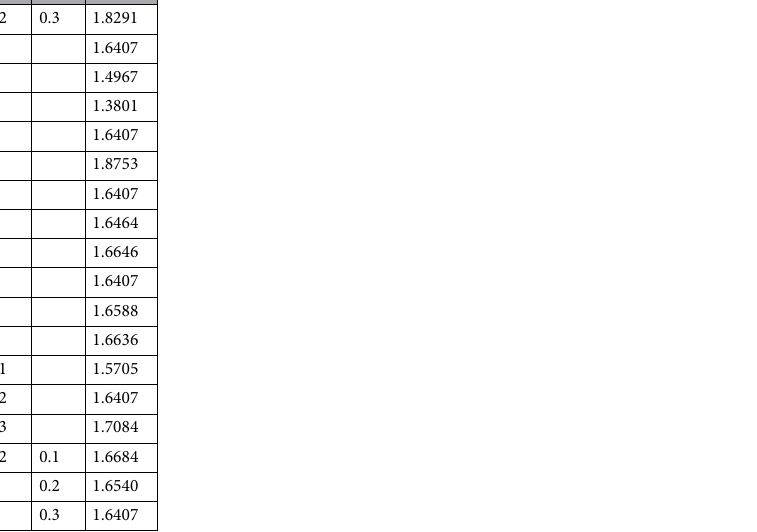
Table 4. Results for Sherwood number